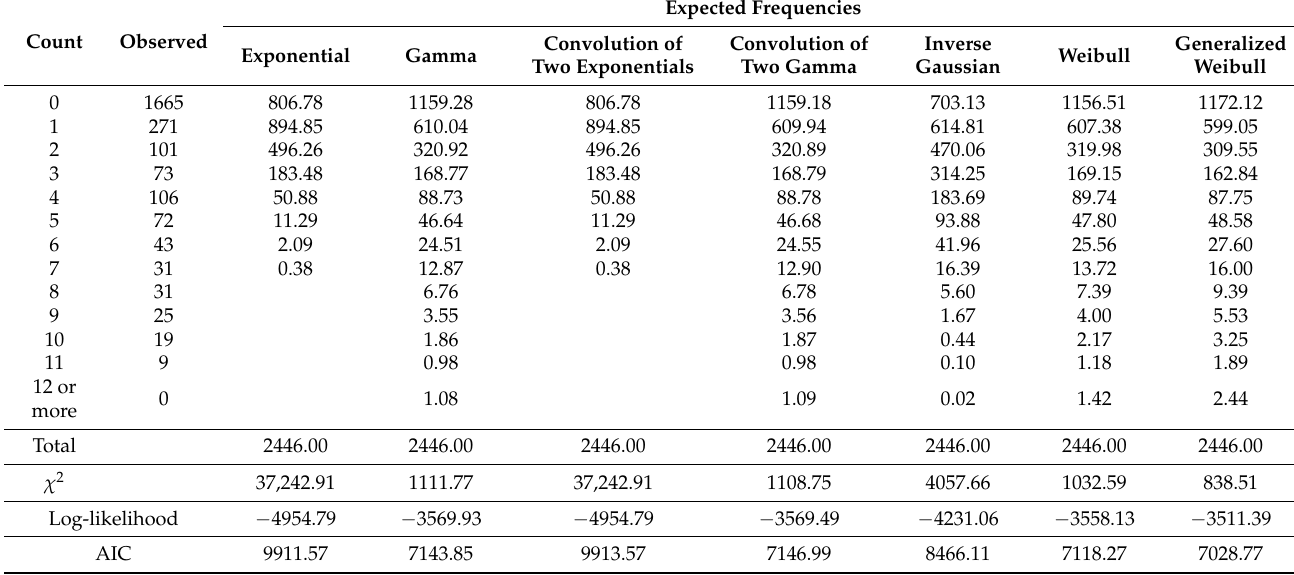
Table 6. Number of monthly non-payments for personal loan (Dionne et al. 1996).